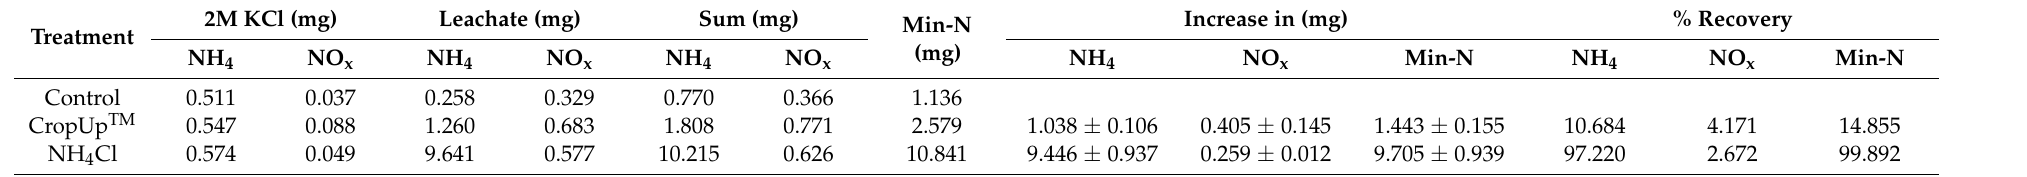
Table 3. Distribution of NH 4 , NO x and mineral N in the soil and leachate, and percentage recovery of added N.